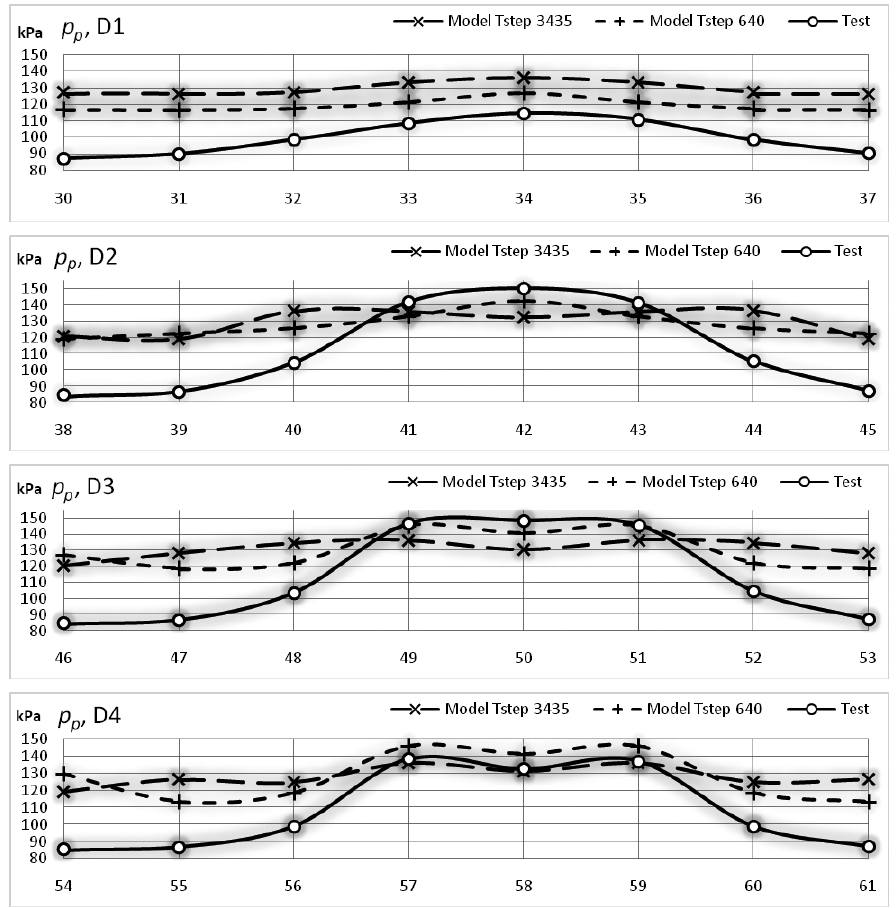
Figure 15. The measuring module total pressure circumferential distribution (at the drainage points according to Figure